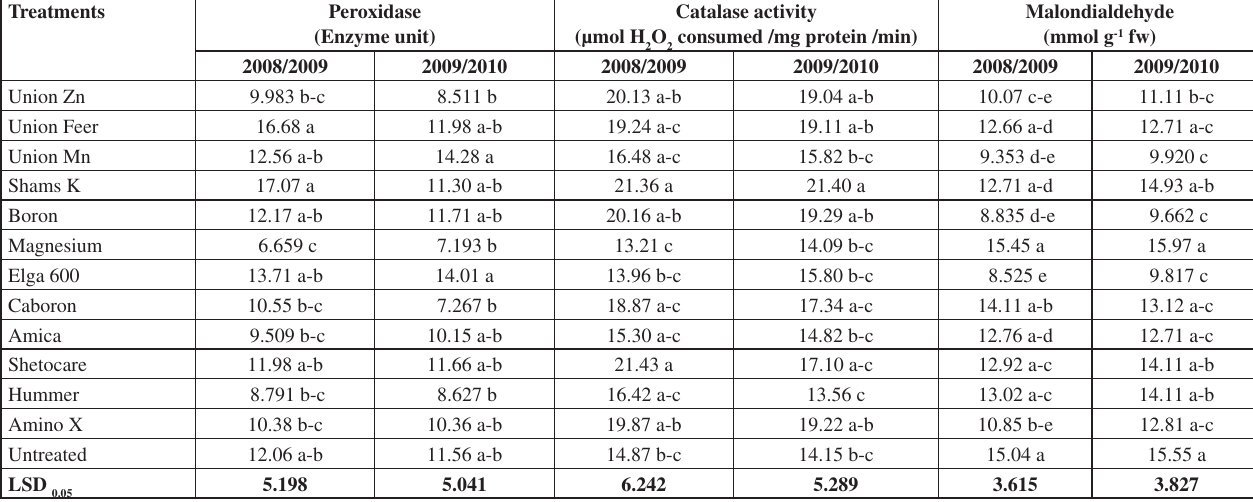
Table 5: Effect of foliar application with commercial compounds on catalase and peroxidase activity and malondialdehyde content of onion seed after harvest in seasons of 2008/2009 and 2009/2010 Treatments